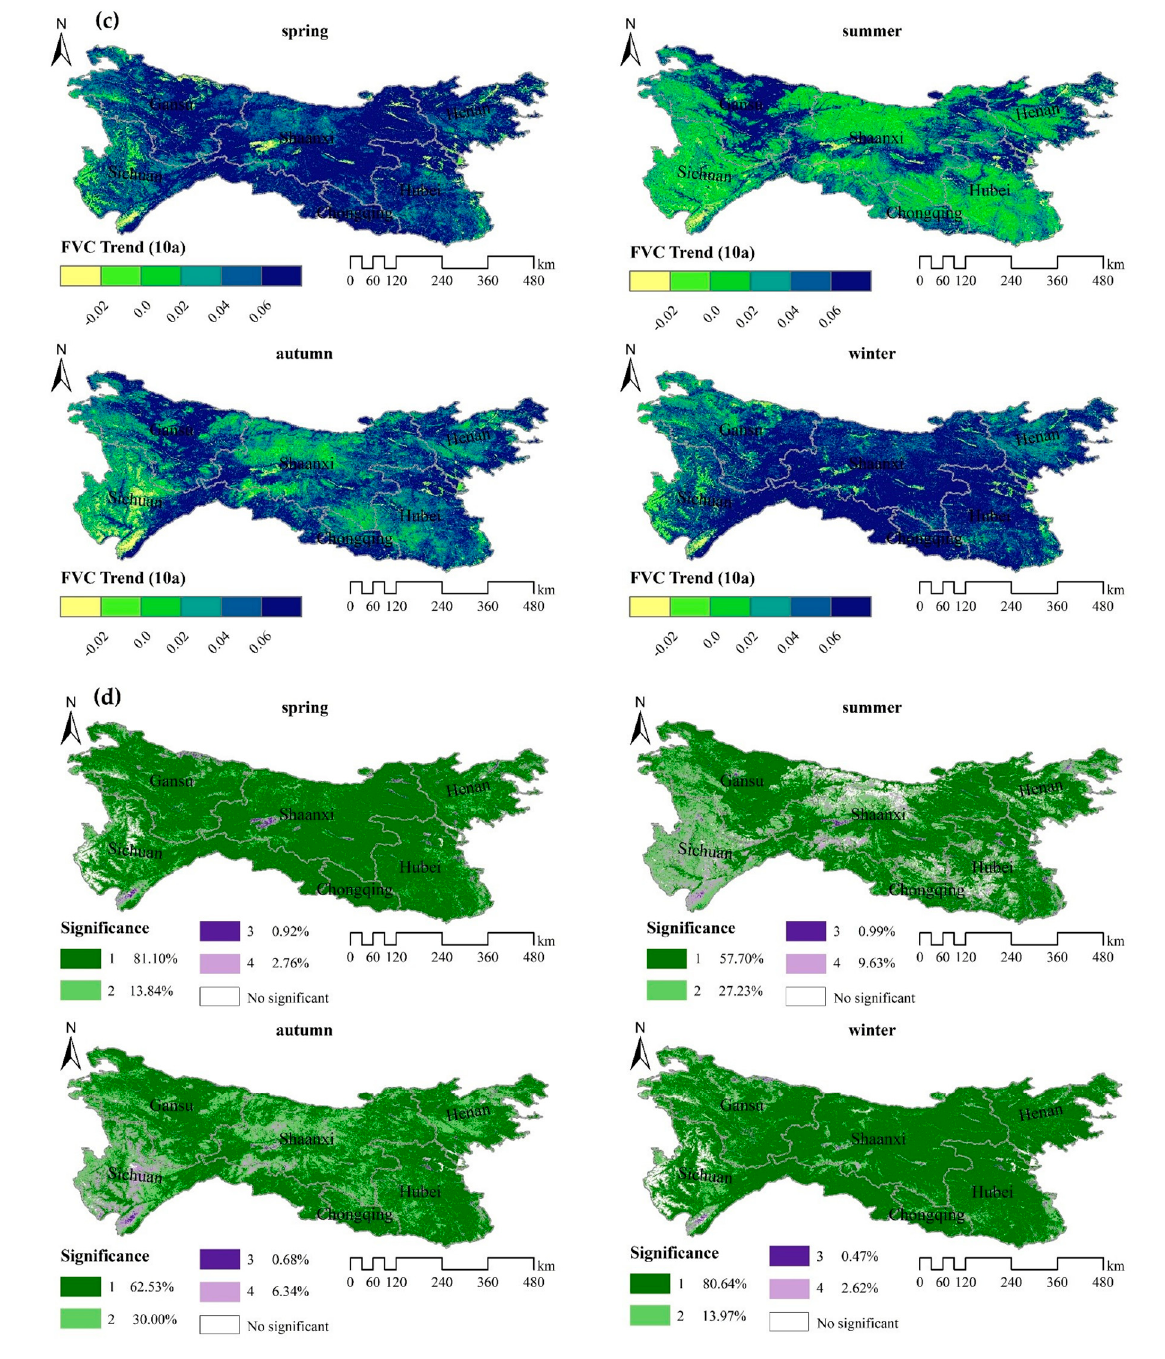
Figure 5. Change of seasonal average FVC spatial pattern in the QBM from 2000–2020. ( a ) Average value; ( b ) FVC level; ( c ) Change trend rate; ( d ) Significance level.